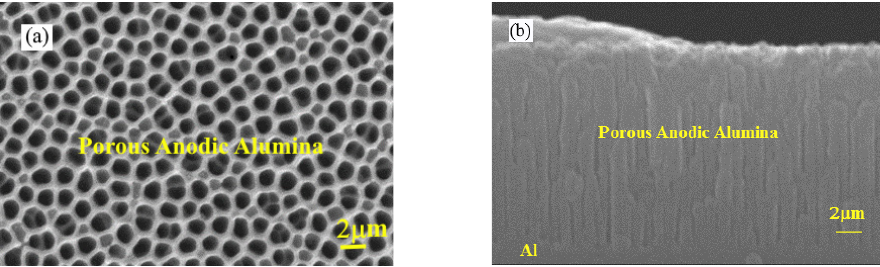
Figure 3. SEM images of porous anodic alumina: ( a ) plan view; ( b ) cross-section view.